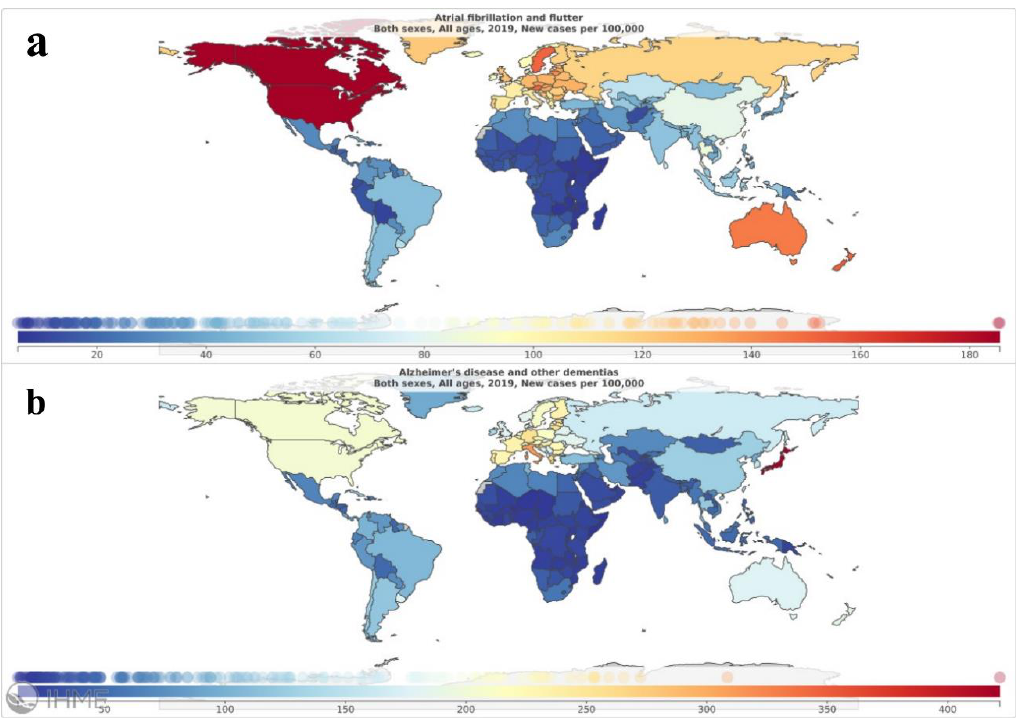
Figure 1. Global maps depicting crude incidence rate of the investigated conditions in 2019: panel ( a ), atrial fibrillation and atrial flutter; panel ( b ) , Alzheimer’s disease and other forms of dementia. Source: https://vizhub.healthdata.org/epi/, (accessed on 12 November 2021). Medicina 2022 , 58 , x FOR PEER REVIEW